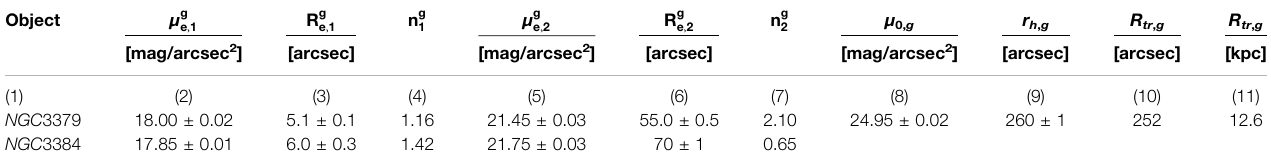
TABLE3| Structuralparametersderivedfromthe1D fi toftheazimuthallyaveragedsurfacebrightnesspro fi lesoftheLEOIpair. Note. Columns2,3,4,5,6,sevenreportthe effective surface brightness, effective radius and Sérsic index for the two inner component of each fi t, in the g band, whereas columns 8 and 9 list the central surface brightnessand scalelength fortheouterexponential component.Columns 9and 10giveatransitionradii, inarcsecand kpcscale respectively,derivedfrom the1D fi tofthe azimuthally averaged surface brightness pro fi les of NGC 3379 (see Section 3.4).